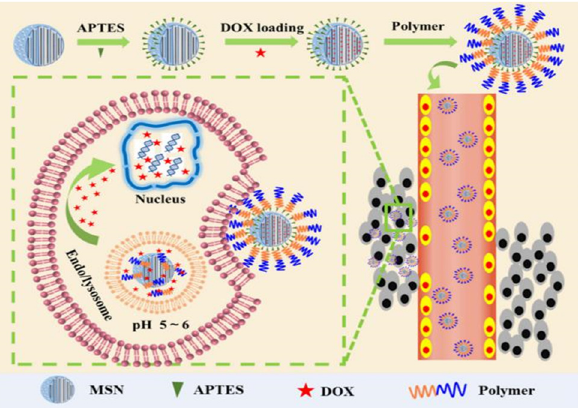
Figure 26: Preparation of polymer@mesoporous SiO 2 - DOX ( doxy - cycline ) and principle of pH induced release [ 164 ] ; Copyright: 2019 with permission from Elsevier Science